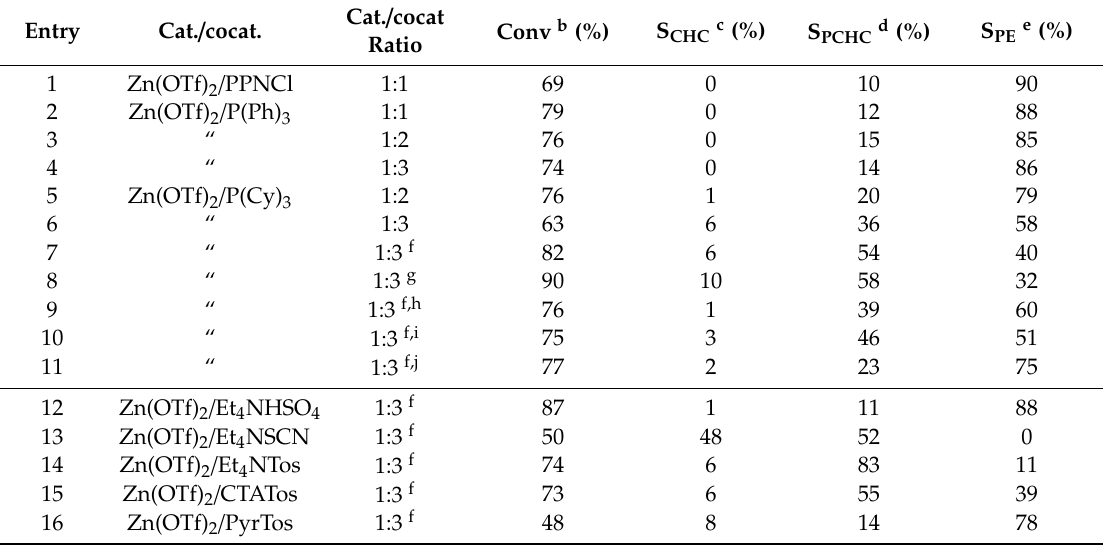
Table 2. Catalytic studies performed with Zn(OTf) 2 catalyst using various cocatalysts a